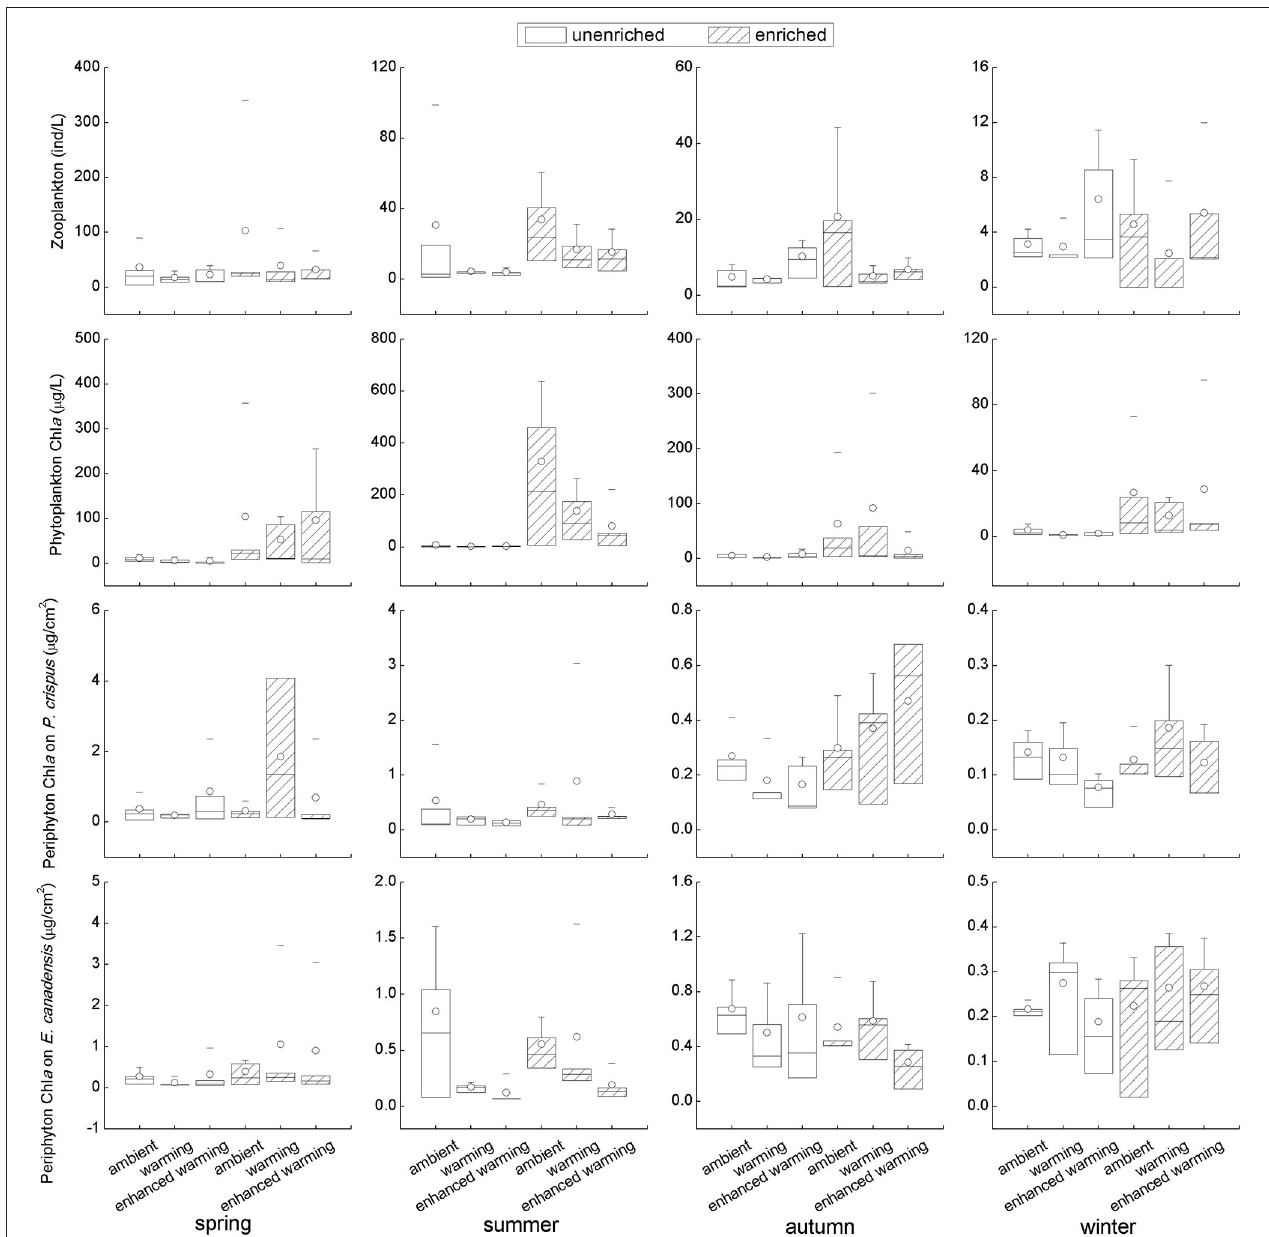
FIGURE 4 | Responses of biotic variables to temperature and nutrients in each season. It should be noted that the vertical scale in each figure was different among